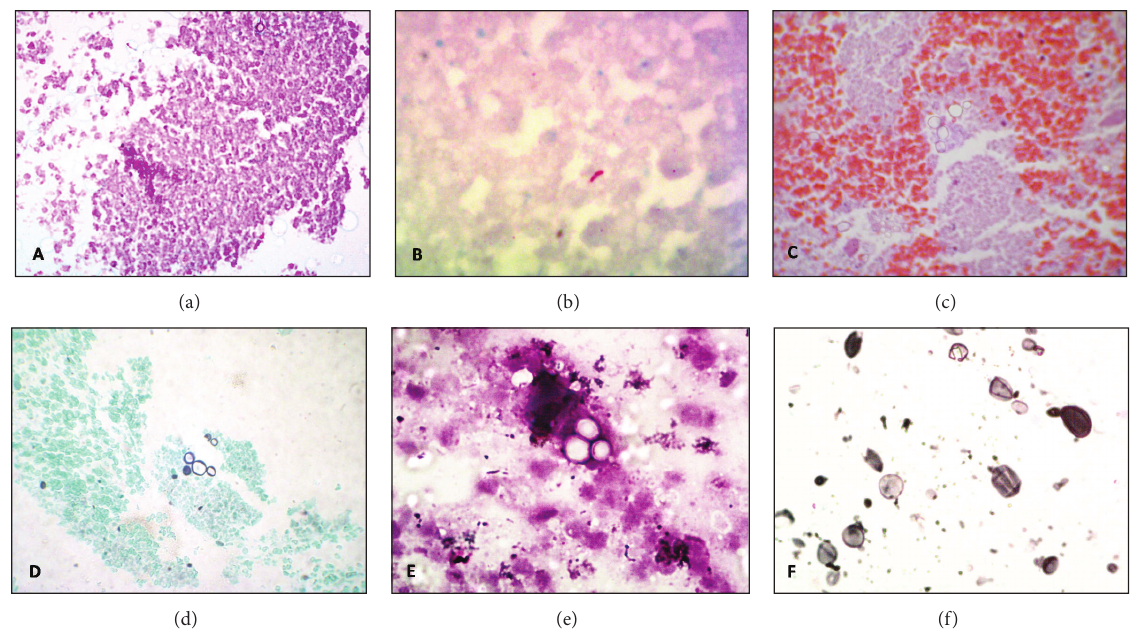
Figure 1: (a) Cell block section showing necrosis (H&E, 40x). (b) Ziehl-Neelsen showing fast-acid bacilli, compatible with tuberculosis. (c) and (e) H&E section from cell blocks from cases 2 and 3 showing fungal structures compatible with Paracoccidioides brasiliensis . (d) and (f) Grocott staining of the cases pictured in (c) and (e) with evidence of the blasts with multiple exofitic